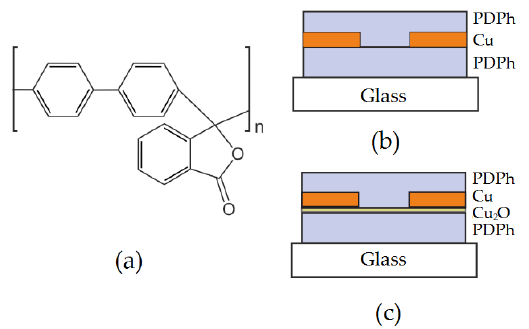
Figure 1. ( a ) Structural formula of PDPh. Schematic representation of the experimental structure of ( b ) PDPh/PDPh and ( c ) PDPh/Cu 2 O/PDPh. ( b ) PDPh/PDPh and ( c ) PDPh/Cu 2